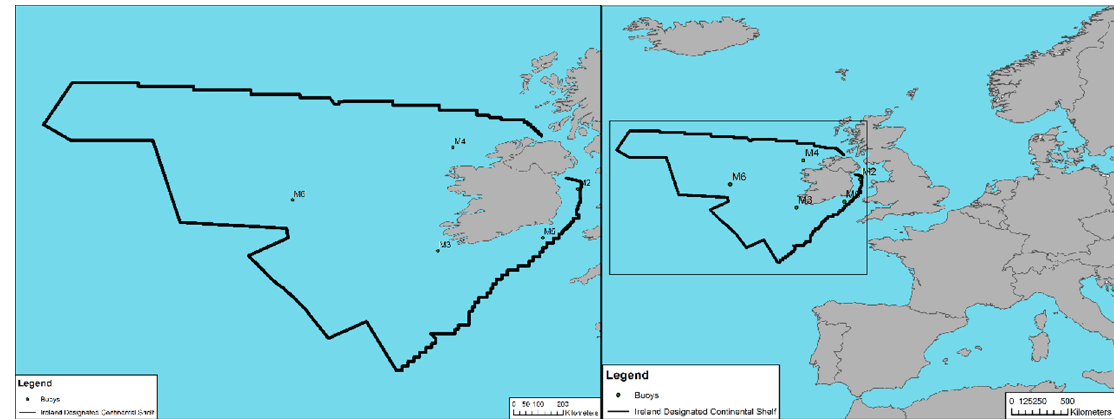
Figure 1. The study area, which was defined by Ireland’s designated continental shelf and location of the M2, M3, M4, M5, and M6 weather buoys.